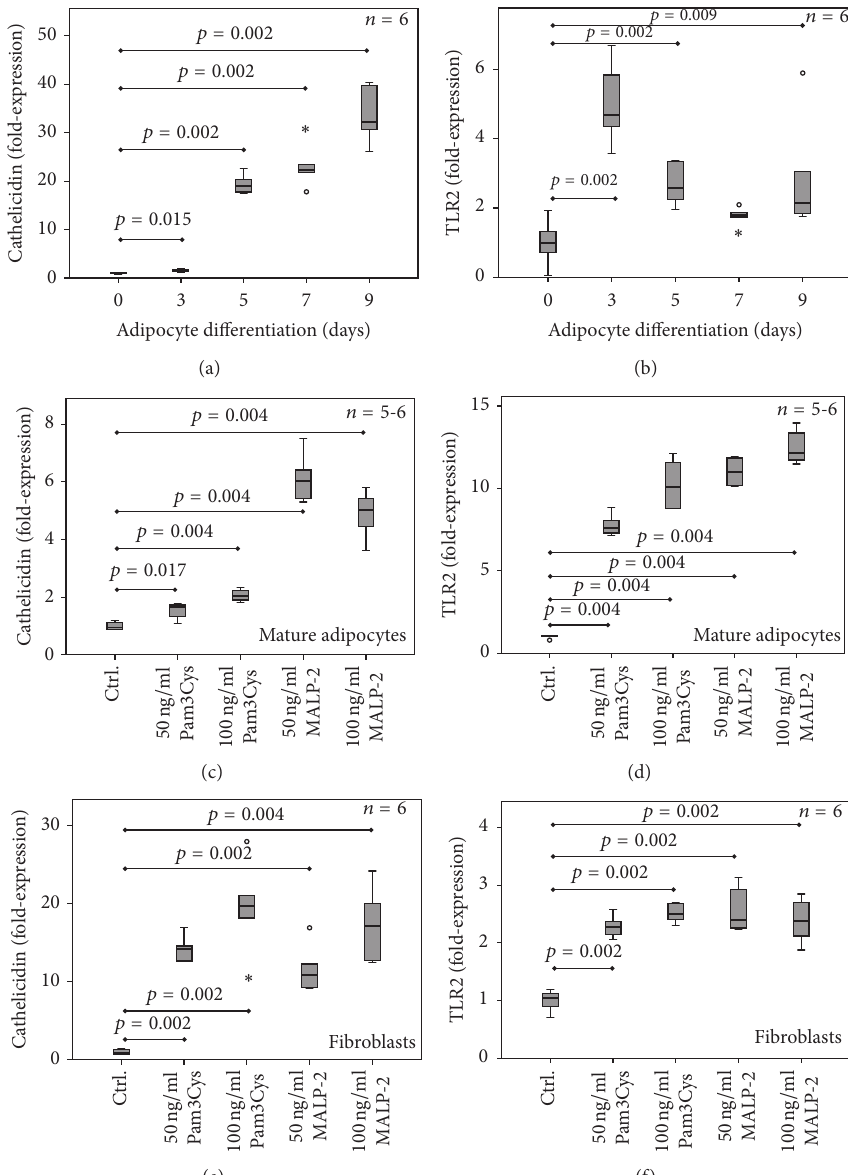
Figure 3: Expression and regulation of cathelicidin and TLR2 during adipocyte differentiation and upon stimulation with the TLR2 agonistic lipopeptides Pam3Cys and MALP-2 . 3T3-L1 fibroblasts were differentiated into mature adipocytes by applying a hormonal differentiation program. Gene expression analysis was performed during adipocyte differentiation at day 0 (fibroblasts), day 3, day 5, day 7, and day 9 (mature adipocytes). 𝑛 = 4–6 wells were analyzed per group. Box plots are shown indicating the median value and upper and lower quartiles, whiskers (1.5-fold of interquartile range). Outliers are marked by circles and asterisks. TLR2, toll-like receptor-2; Pam3Cys, ( S )-(2,3-bis(palmitoyloxy)- (2 RS )-propyl)- N -palmitoyl-( R )-Cys-( S )-Ser( S )-Lys4-OH-trihydrochloride (TLR1/2-agonist); MALP-2, macrophage-activating lipopeptide- 2 (TLR2/6-agonist). (a) Cathelicidin gene expression during 3T3-L1 adipocyte differentiation. Cathelicidin mRNA expression is given as fold- expressioninrelationtoundifferentiatedfibroblastsatday0ofdifferentiation.(b) TLR2geneexpressionduring3T3-L1adipocytedifferentiation. TLR2 mRNA expression is given as fold-expression in relation to undifferentiated fibroblasts at day 0 of differentiation. (c) Cathelicidin gene expression in mature 3T3-L1 adipocytes upon stimulation with the lipopeptides Pam3Cys and MALP-2. Cathelicidin mRNA expression is given as fold-expression in relation to unstimulated control cells. (d) TLR2 gene expression in mature 3T3-L1 adipocytes upon stimulation with the lipopeptides Pam3Cys and MALP-2 . TLR2 mRNA expression is given as fold-expression in relation to unstimulated control cells. (e) Cathelicidin gene expression in 3T3-L1 fibroblasts upon stimulation with the lipopeptides Pam3Cys and MALP-2 . Cathelicidin mRNA expression is given as fold-expression in relation to unstimulated control cells. (f) TLR2 gene expression in 3T3-L1 fibroblasts upon stimulation with the lipopeptides Pam3Cys and MALP-2 . TLR2 mRNA expression is given as fold-expression in relation to unstimulated control cells. “ ∘ ” and “ ∗ ” indicate outliers in the respective data sets displayed as box